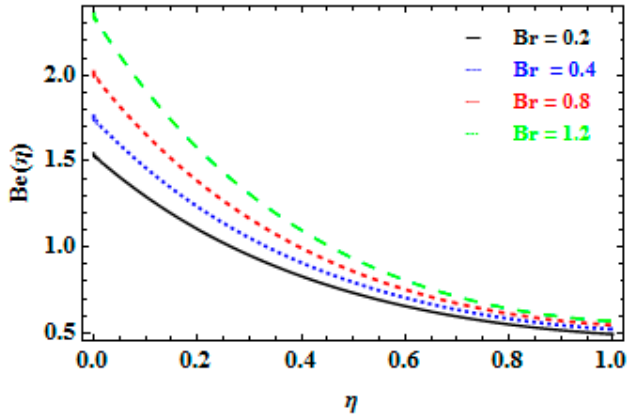
Figure 20. Influence of M on Be( 𝜂 ) .